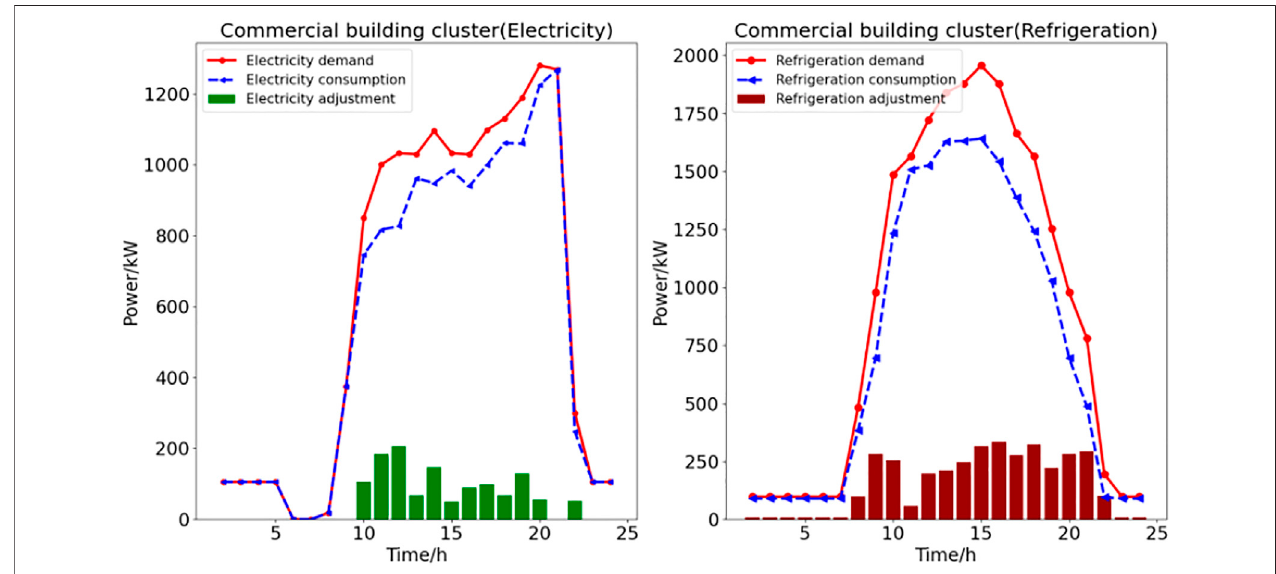
FIGURE 10 | Energy consumption curves of commercial BC.